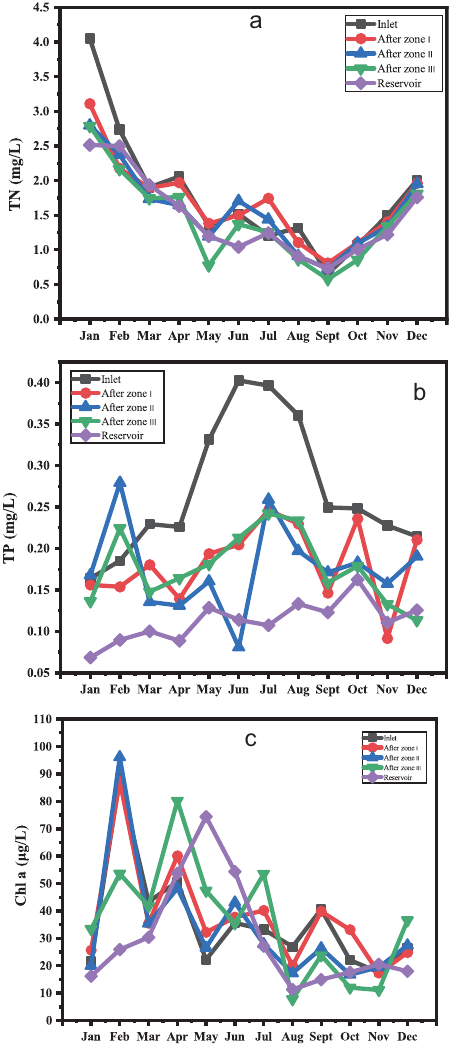
Figure 2. Monthly changes in the concentrations of ( a ) total nitrogen (TN), ( b ) total phosphorus (TP), and ( c ) chlorophyll a (Chl a) in the inlet and four treatment zones in the